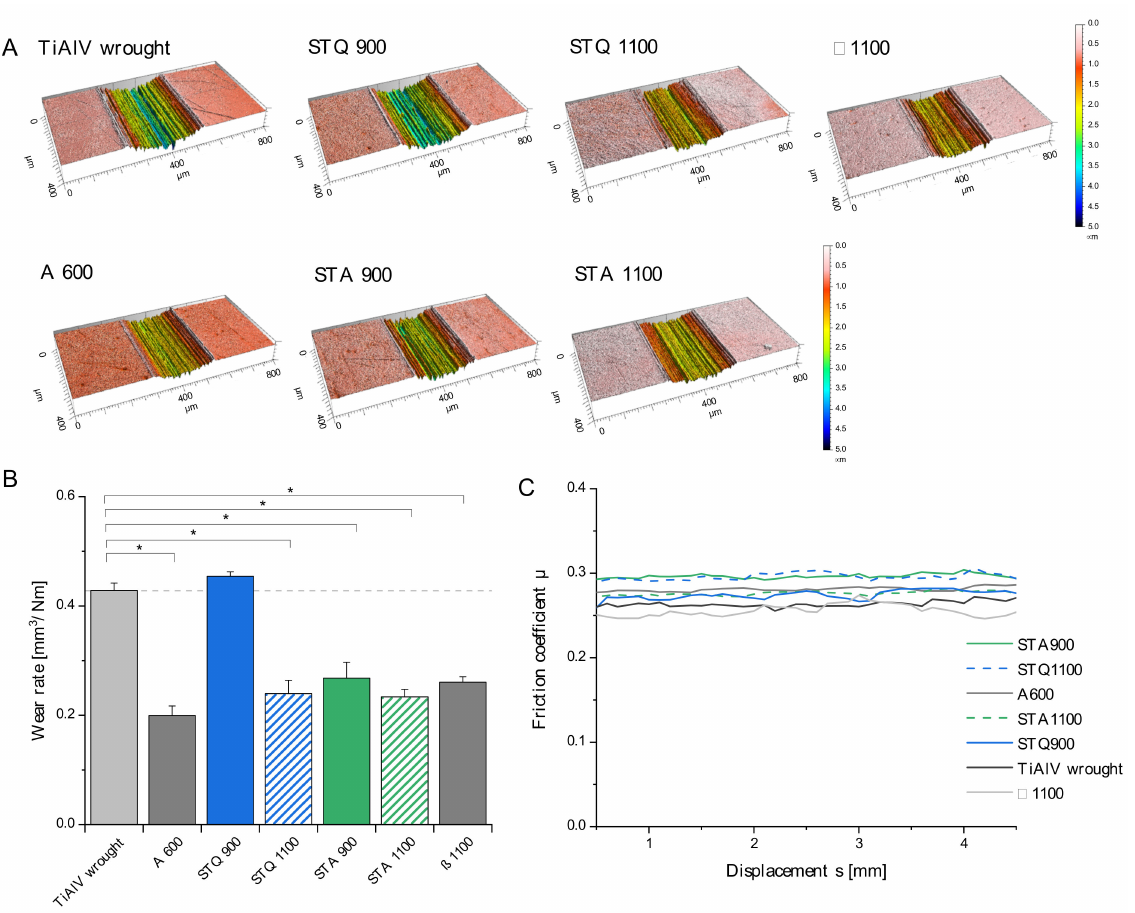
Figure 5. Tribological behavior of the heat-treated TiAl6V4 alloys tested against an alumina ball under serum lubrication. ( A ) Depth-colored confocal images of representative wear tracks generated during the tribological test. ( B ) The calculated mean wear rates show a significant reduction for the heat treated samples A 600, STQ 1100, STA 900, STA 1199 and β 1100 compared to the wrought condition (two-way ANOVA, post-hoc t -test,* p < 0.05). ( C ) Courses of the monitored mean friction coefficient for the tested samples (data as mean ± SD, n = 3, N = 3). The color-coded wear marks reveal a depth-dependent variation for the tested samples. Accordingly, the TiAl6V4 wrought alloy and STQ 900 samples exhibit the deepest wear